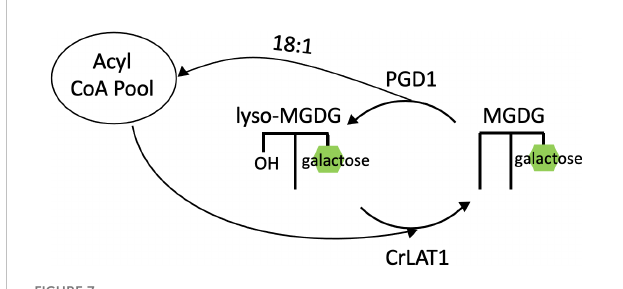
FIGURE 7 Acyl editing cycle of MGDG in C. reinhardtii . Removal of 18:1 from newly made MGDG at the sn -1 position by PGD1, and reacylation of lyso-MGDG catalyzed by CrLAT1. CrLAT1, C. reinhardtii Lysolipid Acyltransferase 1; MGDG, monogalactosyldiacylglycerol; PGD1, Plastid Galactoglycerolipid Degradation